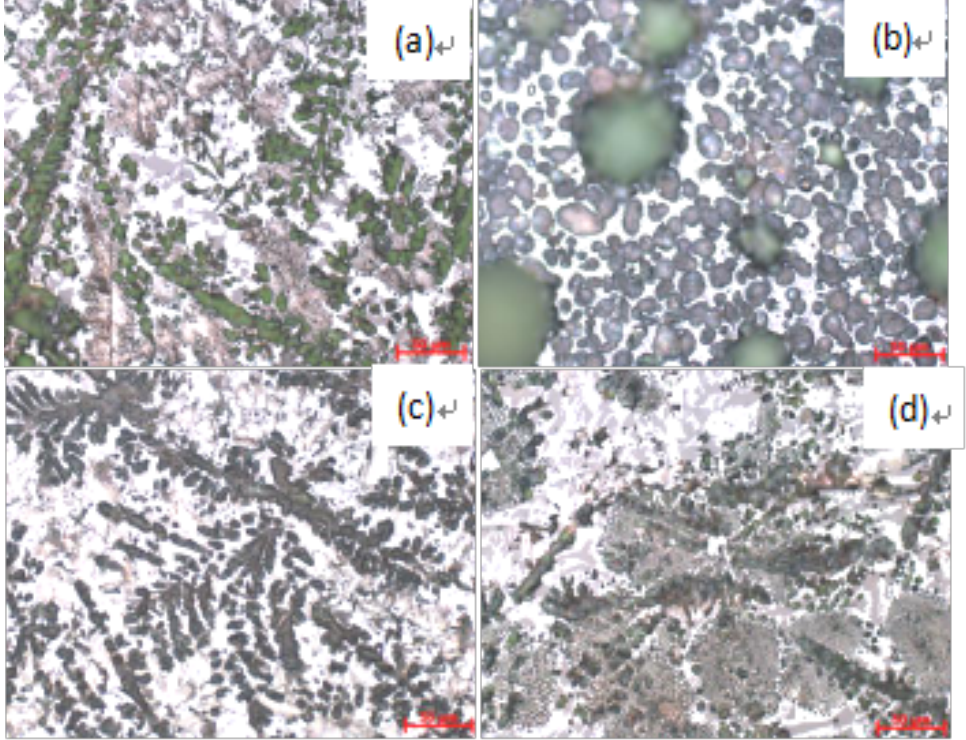
Figure 11: Lithofacies test images of reconstructed steel slag with different CaSO 4 contents. (a) 0, (b) 2, (c) 3, and (d) 4 wt% CaSO 4